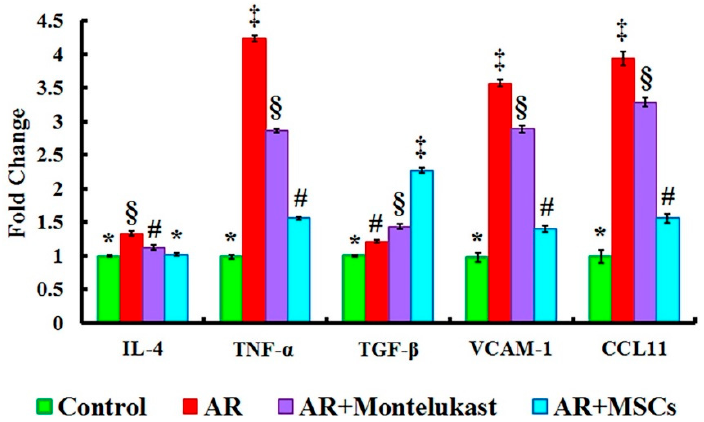
Figure 4. Quantitative analysis for relative IL-4, TNF- α , TGF- β , VCAM-1 and CCL11 genes expression after the indicated treatment with Montelukast or MSCs. Different superscripts (*, #, §, and ‡) at the same check point to significant differences at p < 0.05. Data are shown as mean ± S.E.M, n = 5.